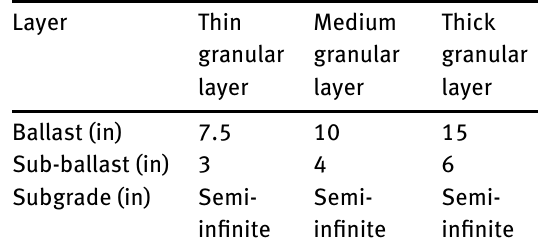
Table 11: Granular rail track geometry and layer